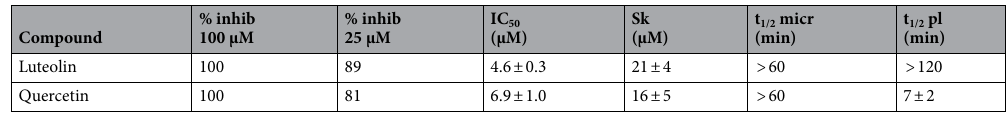
Table 1. In vitro inhibitory activity against SARS-CoV-2 RdRp, kinetic solubility (Sk) in neutral water, microsomal stability (t 1/2 micr.) in mouse, and plasma stability (t 1/2 pl.) in mouse of luteolin and